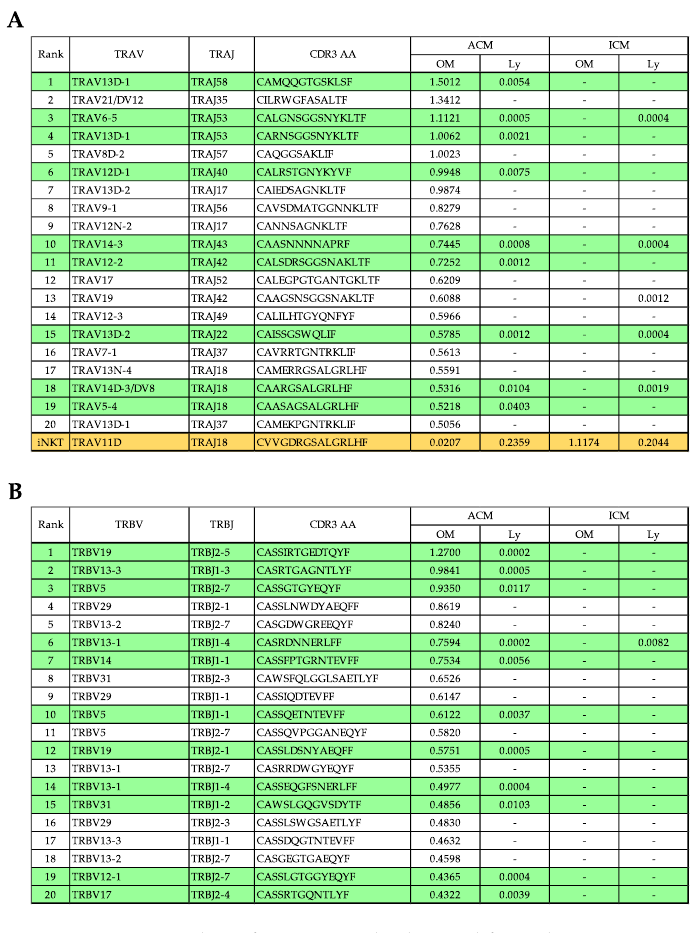
Figure 6. Commonality of unique reads obtained from the repertoire analysis in TRA and TRB. ( A , B ) The %frequency of unique reads in the top 20 in ACM OM mice and their commonality in other samples. The %frequency is the average of the frequency of presence for in–frame reads for each of the three independent samples. The green shading is unique reads shared by ACM OM and ACM Ly mice. ( A , B ) Orange shading included iNKT cell sequences as detected in all samples. ( A ) iNKT cell sequence and %frequency of presence in each sample. The %frequency is the average of the frequency of presence for in–frame reads for each of the three independent samples.